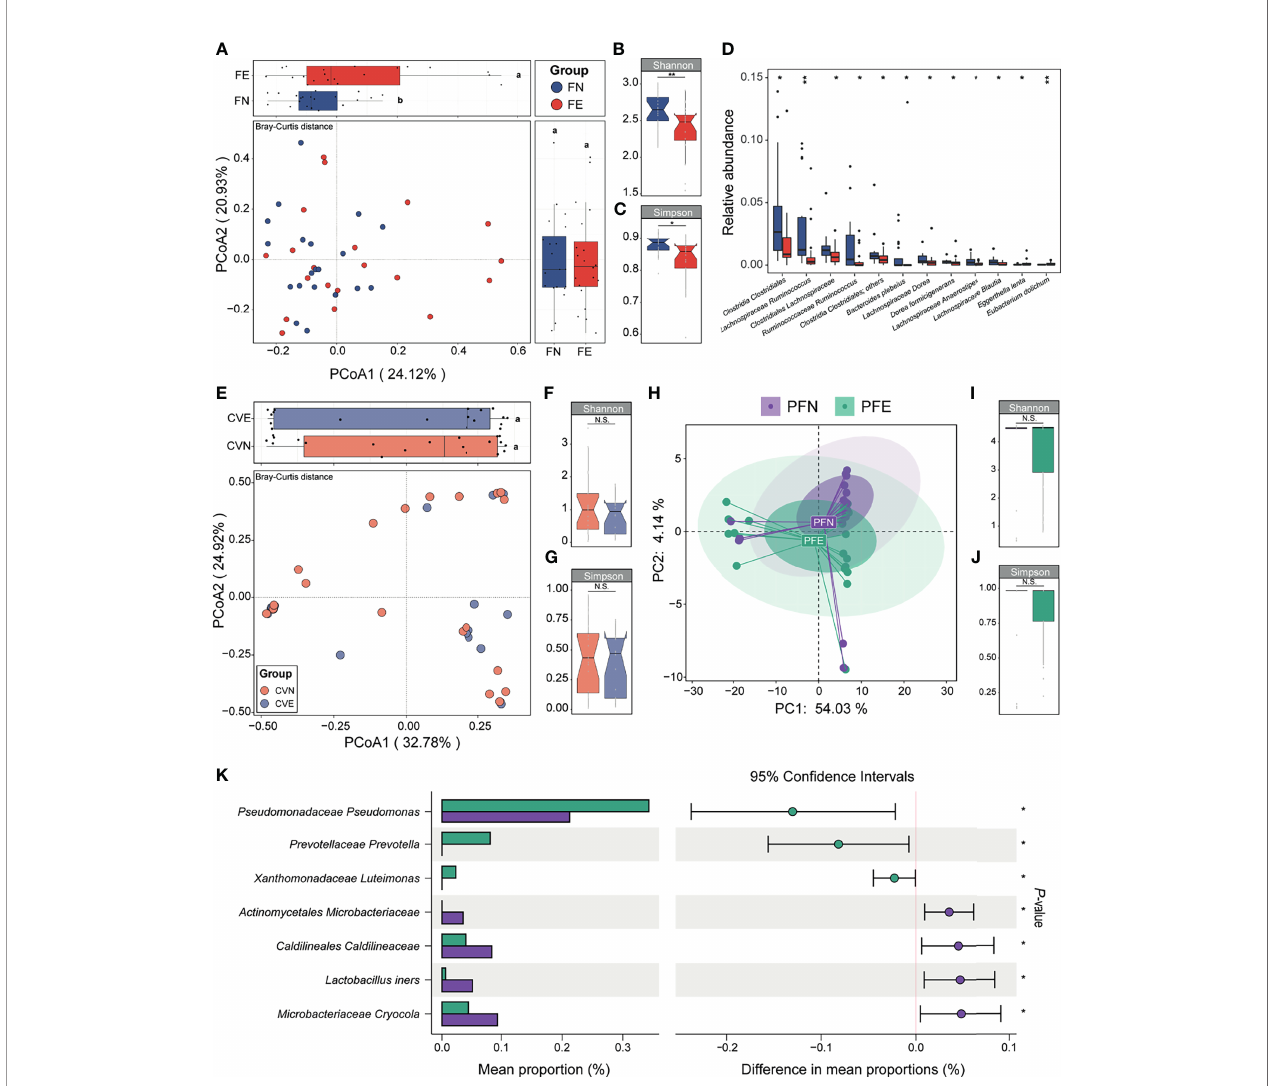
FIGURE 3 | Between-group and within-group microbial community differences in control and EM individuals. (A) Fecal microbial community structural difference between controls and EM individuals by PCoA plotting based on Bray – Curtis dissimilarity data sets at the species level. Different letters (a, b) indicate signi fi cant difference (p < 0.05) between groups according to the least signi fi cant difference (LSD). (B, C) Differences in alpha-diversity between the control clusters from EM. (D) Box plots illustrated the relative abundance of differential bacteria between groups; box boundaries show quartile. (E) Cervical mucus microbial community structural difference between controls and EM individuals by PCoA plotting based on Bray – Curtis dissimilarity data sets at the species level. (F, G) Differences in alpha-diversity between the control clusters from EM. (H) Peritoneal fl uid microbial community structural difference between controls and EM individuals by principal component analysis plotting based on taxonomic data sets at the species level. (I, J) Differences in alpha-diversity between the control clusters from EM in PF samples. (K) Seven taxa were signi fi cantly different between groups. The p value denotes two-tailed Student ’ s t -test. N.S., not signi fi cant, *p < 0.05, **p <